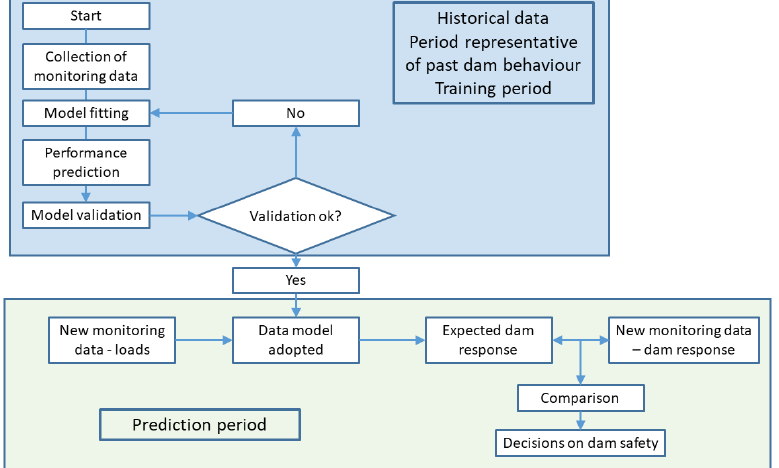
Figure 3. General scheme for fitting and applying predictive models based on monitoring